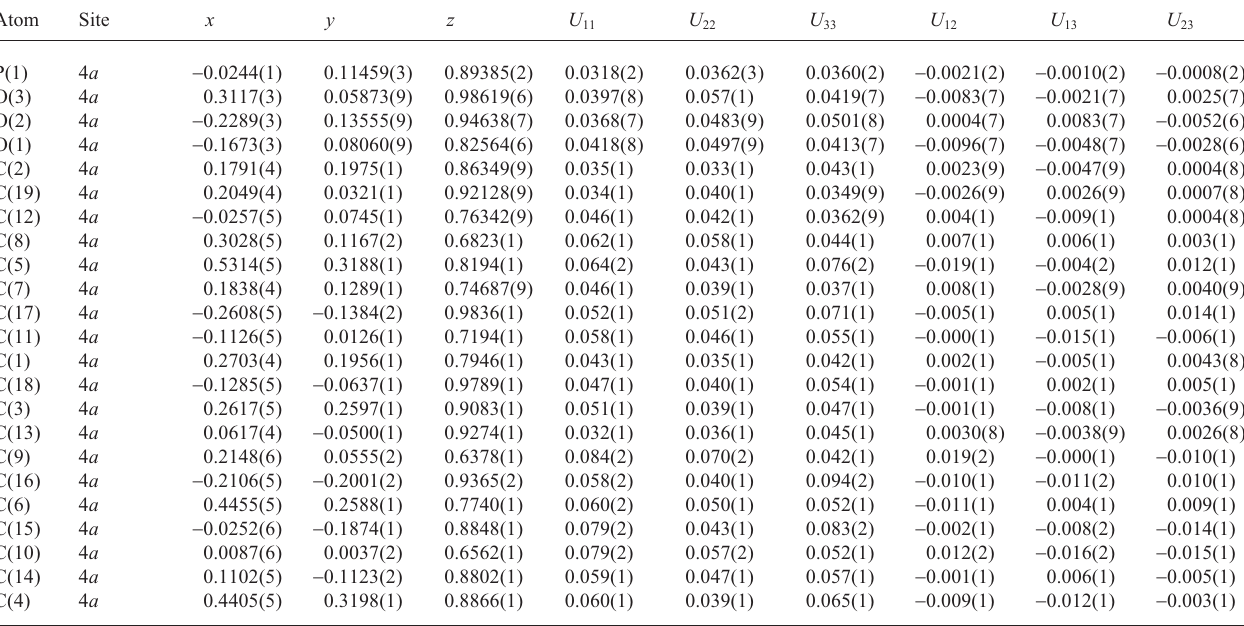
Table 3. Atomic coordinates and displacement parameters (in Å 2 )